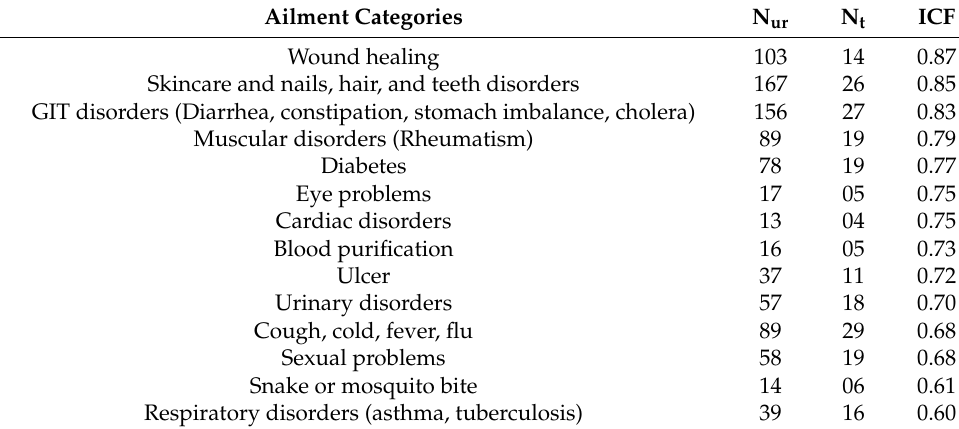
Table 3. ICF values of the medicinal plant species exploited for the treatment of several ailment